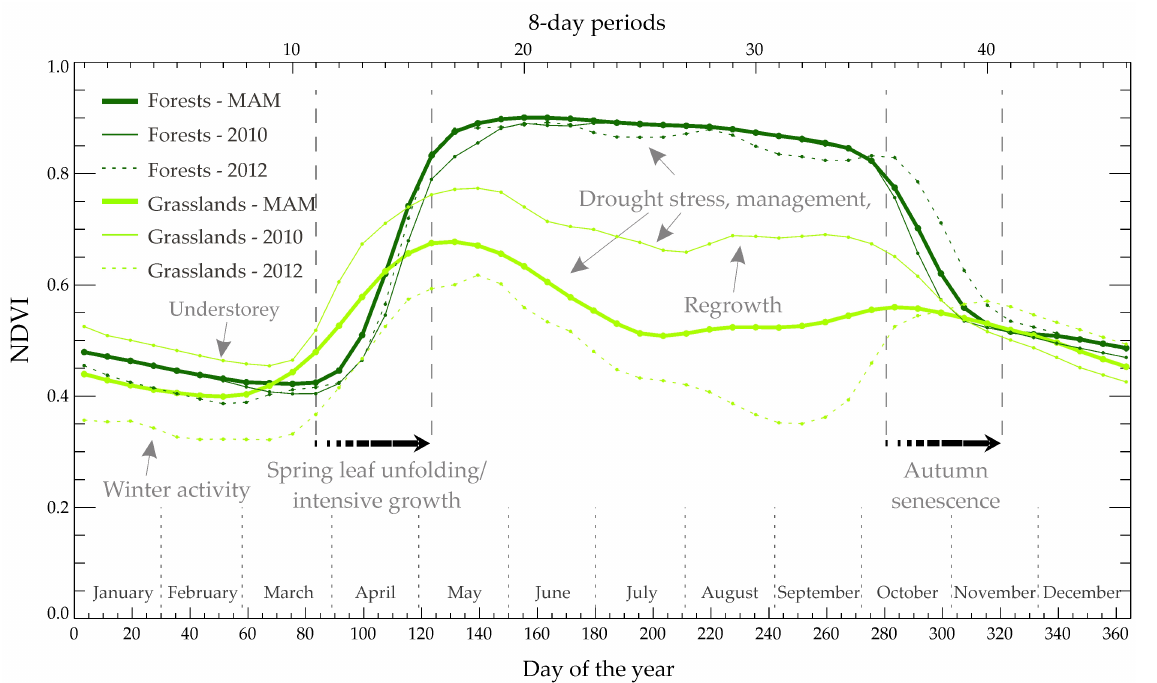
Figure 2. Conceptual figure of illustrative phenological profiles of broad-leaved forests ( Sessile oak with hornbeam ) and grasslands ( Grassland on saline soil ), with the indication of the most important phenophases. Phenological profiles are presented for the multiannual means (MAM) and for two selected